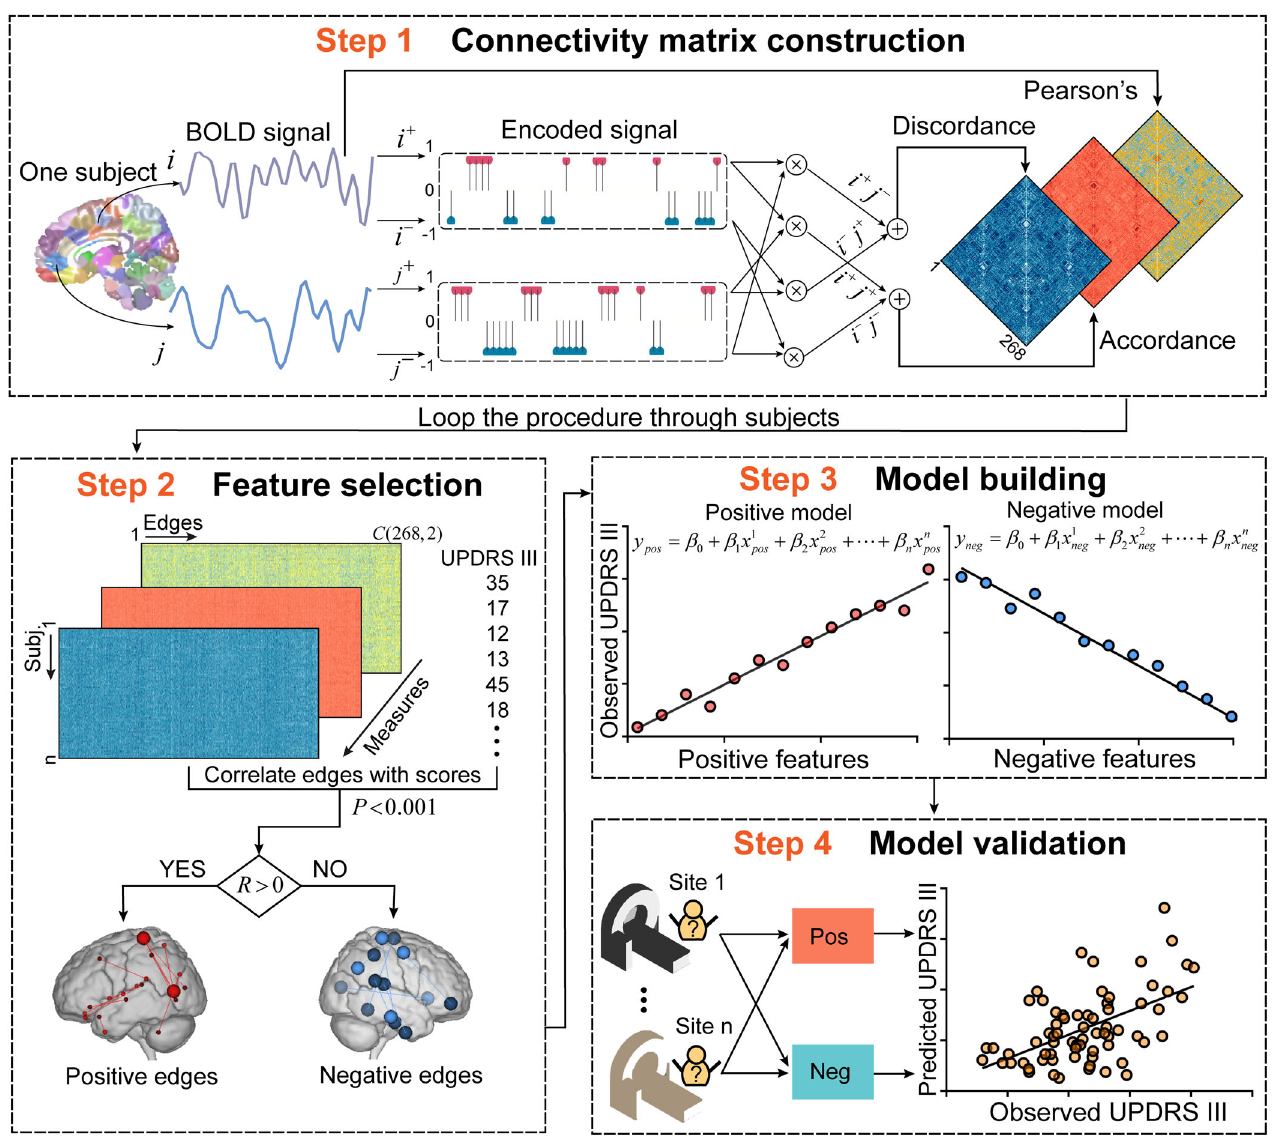
Fig. 1 Schematic representation of connectome-based predictive modeling for motor dysfunction in PD. Step 1: We extracted the mean signal from regions of interest (ROIs), then positive extreme values of the z-transformed time series were encoded as 1, whereas negative extreme values were encoded as -1. The encoded series was subsequently sent into two layers. The fi rst layer (dot product layer) produced sub-states of connectivity for each pair of ROIs, and the last layer (accumulation layer) quanti fi ed the synchronized interactions (accordance) and antagonistic interactions (discordance). Connectivity matrices based on three FC measures were constructed for each subject. Step 2: We looped step 1 through subjects and created a group-level matrix ( m × n , where m represents subjects, and n represents FC). The signi fi cantly motor-correlated edges ( P < 0.001) were selected and divided into positive features ( R > 0) and negative features ( R < 0). Step 3: We trained a multivariate linear regression model using partial least squares based on selected features. Step 4: Apply models to novel subjects in independent samples to assess the generalizability. Brain images in this fi gure were obtained from the Bioimage Suite (https:// bioimagesuiteweb.github.io/webapp/), which is an open source software package. UPDRS III Uni fi ed Parkinson ’ s Disease Rating Scale motor examination; FC functional